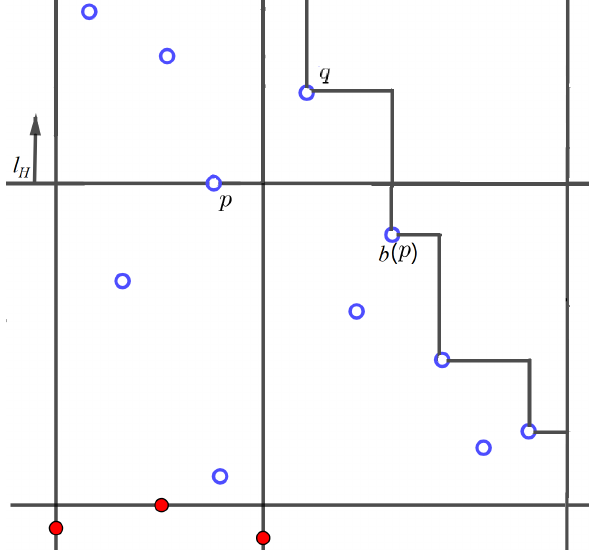
Figure 8. Case 5. p ∈ B N , q ∈ B NE and q is to the left of b ( p ) . Case 6. If q ∈ B N , then, if t = k NNE − 1, we add ( q , s ) to S t + 1 for every ( p , s ) ∈ S t (Figure